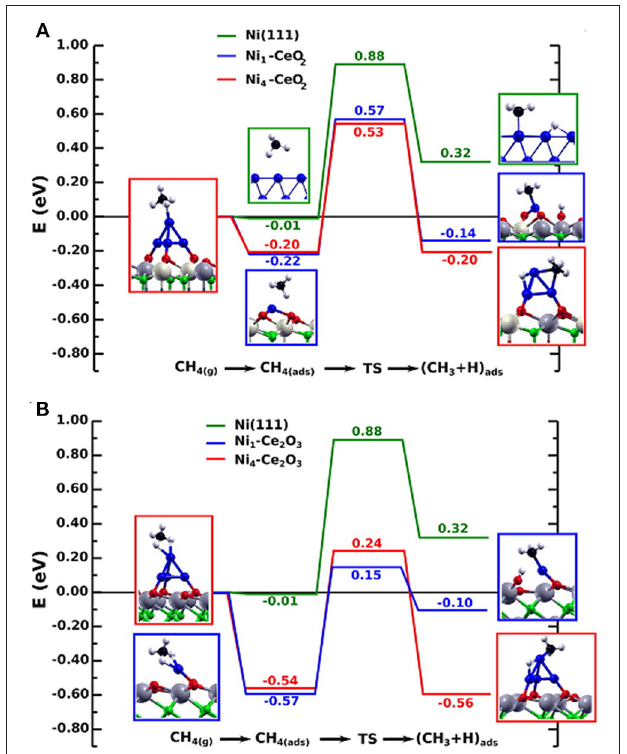
FIGURE 4 | Reaction energy profile for the CH 4 → CH 3 + H reaction on isolated Ni atoms and Ni 4 clusters on the CeO 2 (111) (A) and Ce 2 O 3 (0001) surfaces (B) , in comparison to Ni(111). The structures shown to the left and right of the reaction pathways correspond to the side views of the optimized molecularly adsorbed and dissociated states used in the search of the transition state structure. All energies are relative to CH 4 in the gas phase. Reproduced from Lustemberg et al. (2016), with permission of ACS publications.